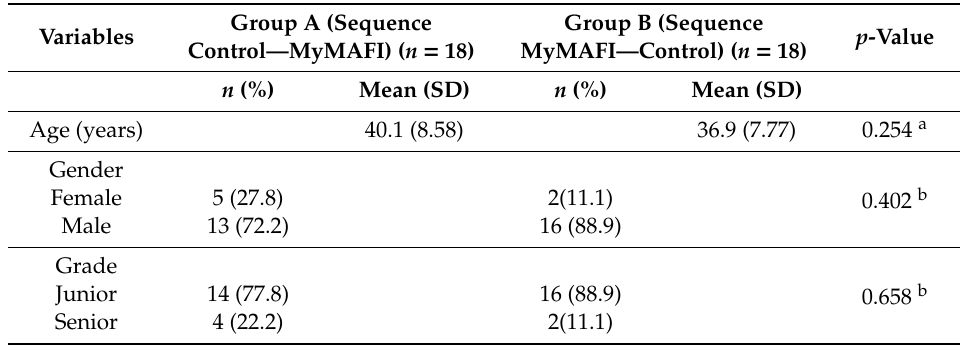
Table 1. Comparison of baseline participants’ characteristics between group. MyMAFI: My Mobile Apps for Field